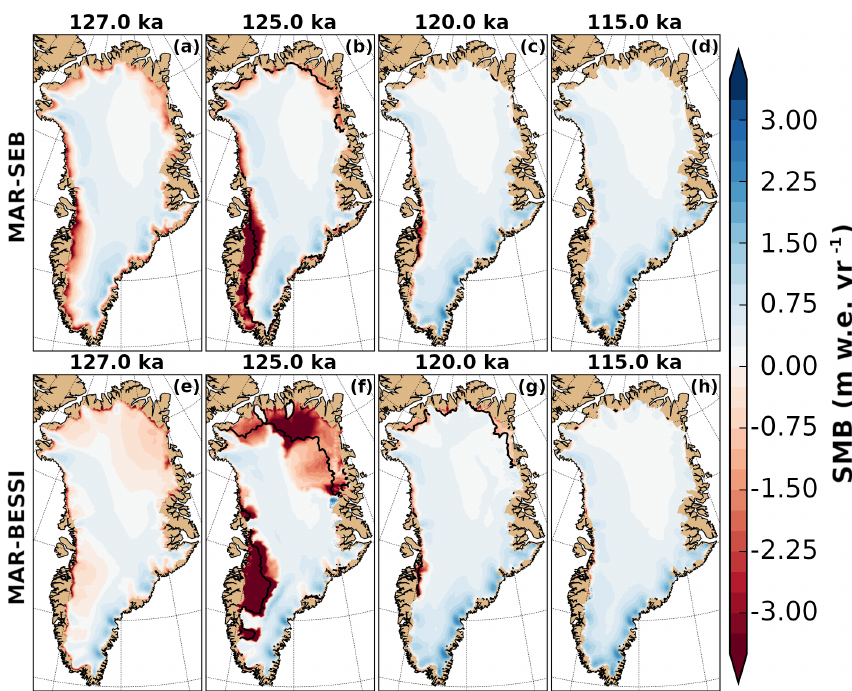
Figure 3. SMB forcing corrected for surface elevation changes at 127, 125, 120, and 115ka for the control ( a–d , MAR-SEB) and the SMB ( e–h , MAR-BESSI) experiments. The ice margin is indicated with a solid black line (10m ice thickness remaining). A nonvisible ice margin is identical to the domain margin. For a consistent comparison, the SMB is shown at 125ka instead of the individual minimum ( control at 124.7ka and SMB at